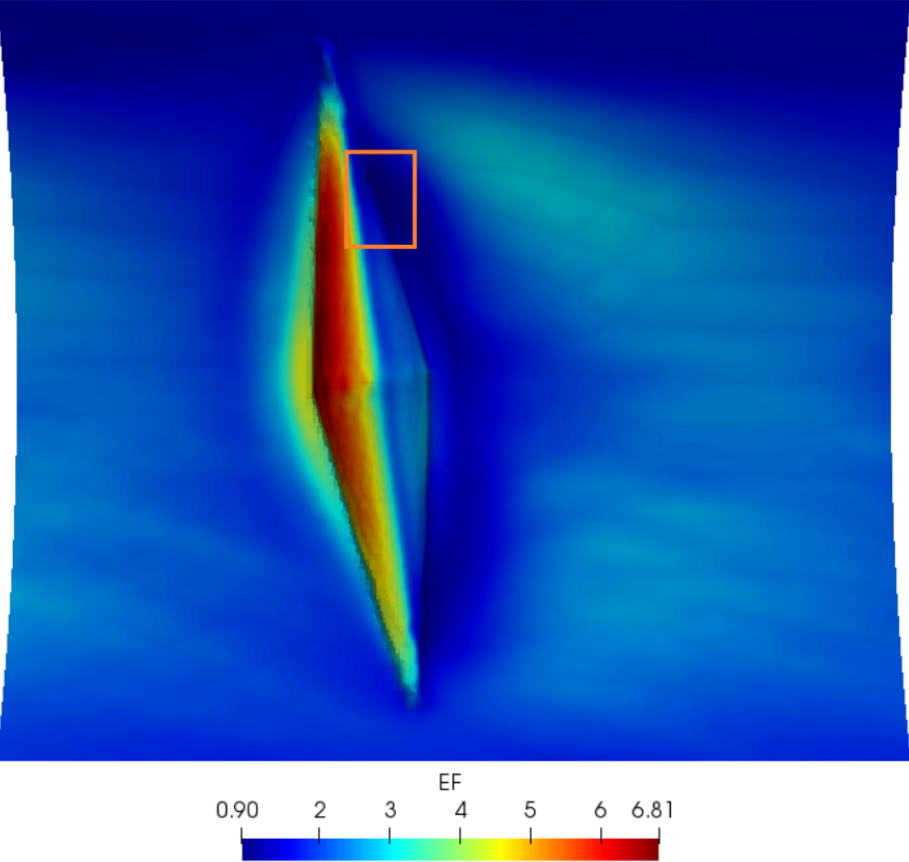
Figure 14. Representation of the ratio of Nusselt number to Nusselt number smooth pipe over a complete